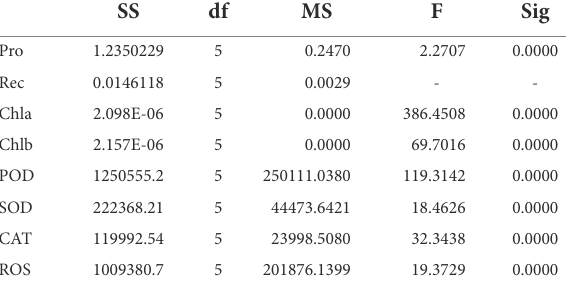
TABLE 3 ANOVA of H. virescens phenotypic data (Treatment vs.